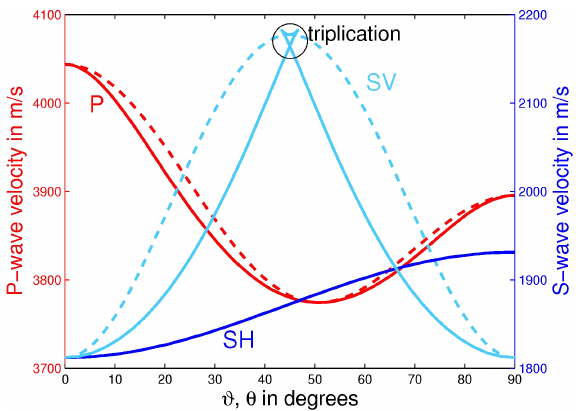
Figure 3. Phase (dashed lines) and group velocities (solid lines) over the corresponding phase ϑ and group angle θ for P (red curves), SH (blue curves) and SV waves (light blue curves) of a VSM fabric. The SV-wave group velocity shows a triplication for group angles θ between 43 and 47 ◦